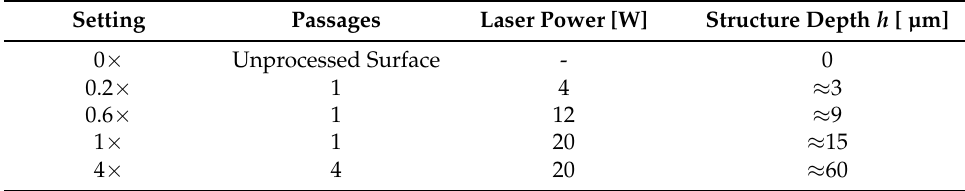
Table 3. Laser power settings